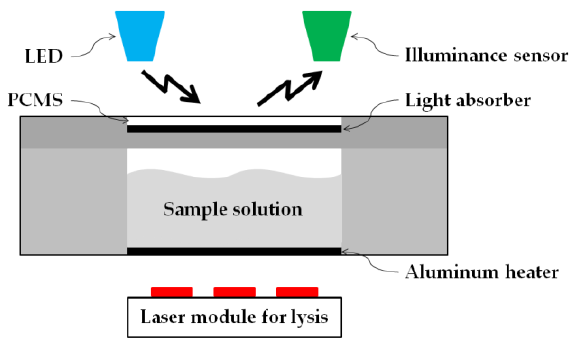
Figure 4. Schematic diagram that consists of phase change material sheet (PCMS) and illuminance sensor to measure the temperature of the lysis chamber being heated by laser module.